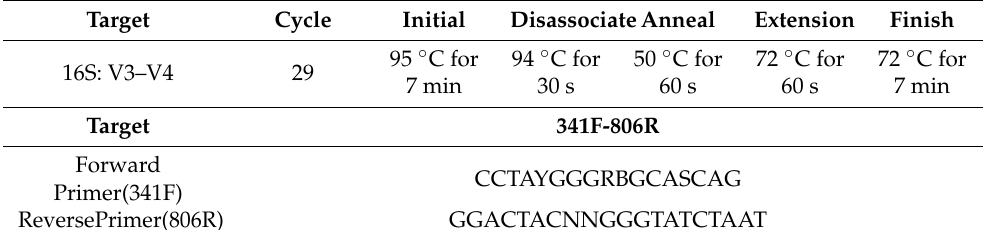
Table 1. Generation of amplicons using primers and conditions outlined (Australian Genome Research Facility, AGRF, Melbourne, Australia). Target Cycle Initial DisassociateAnneal